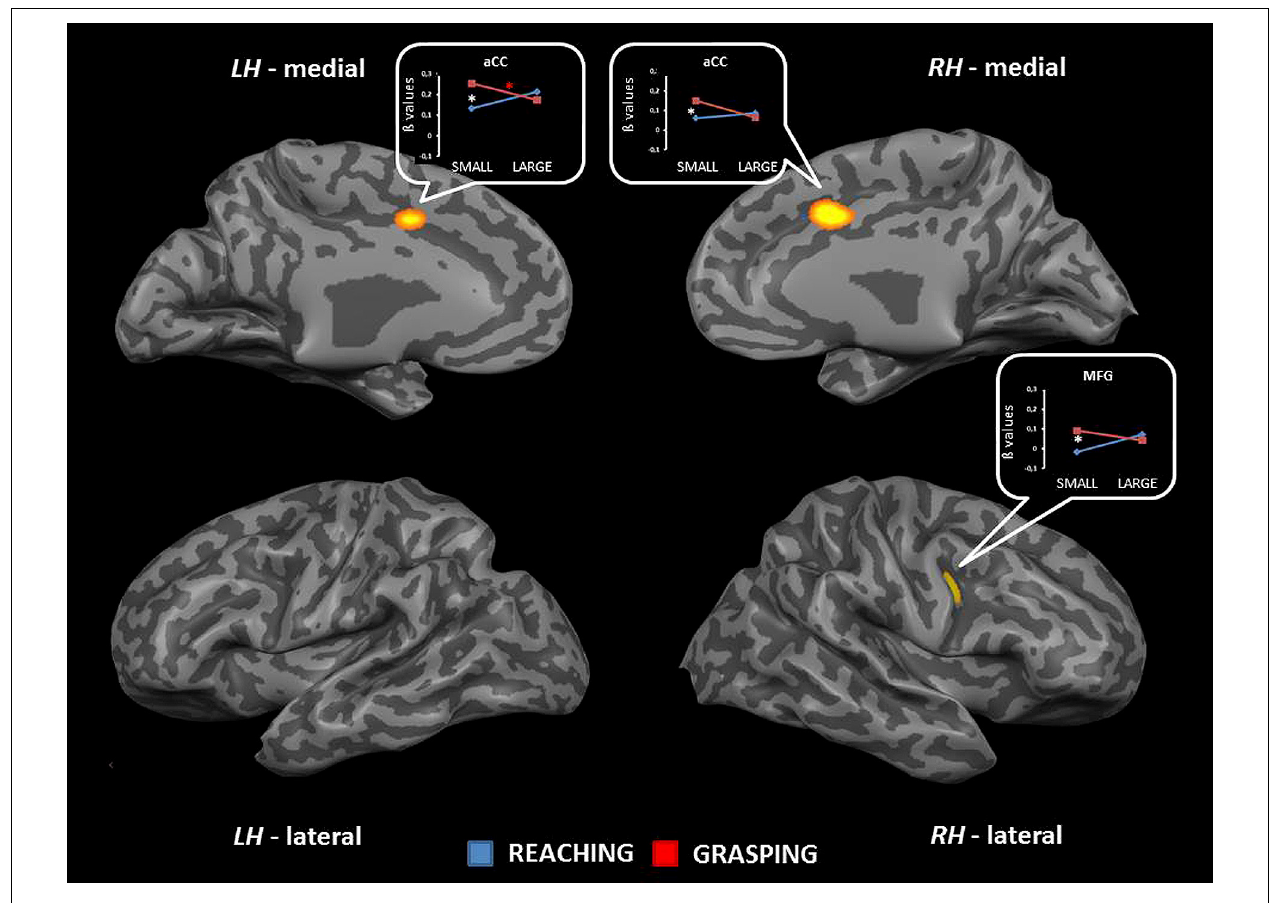
FIGURE 3 | Brain regions showing significant interaction effects between type of movement and stimulus dimension in TB 5. The p value is set to 0.001, uncorrected for multiple comparisons, cluster size k ≥ 13. White asterisks indicate significant effects for the contrast